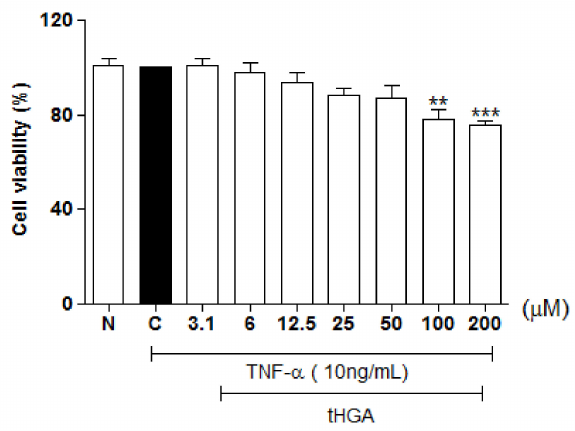
Figure 1. The effect of tHGA on the viability of human alveolar epithelial cells. A549 cells were stimulated with 10 ng/mL of TNF- α and treated with increasing concentrations of tHGA for 24 h, followed by assessment of cell viability by MTT assay. The values are expressed as mean ± SEM of three independent experiments performed in triplicates, where ** p ≤ 0.01, *** p ≤ 0.001 versus TNF- α -induced cells, according to post hoc comparison using Dunnett’s test. C: TNF- α -induced cells; N: normal and non-induced cells.